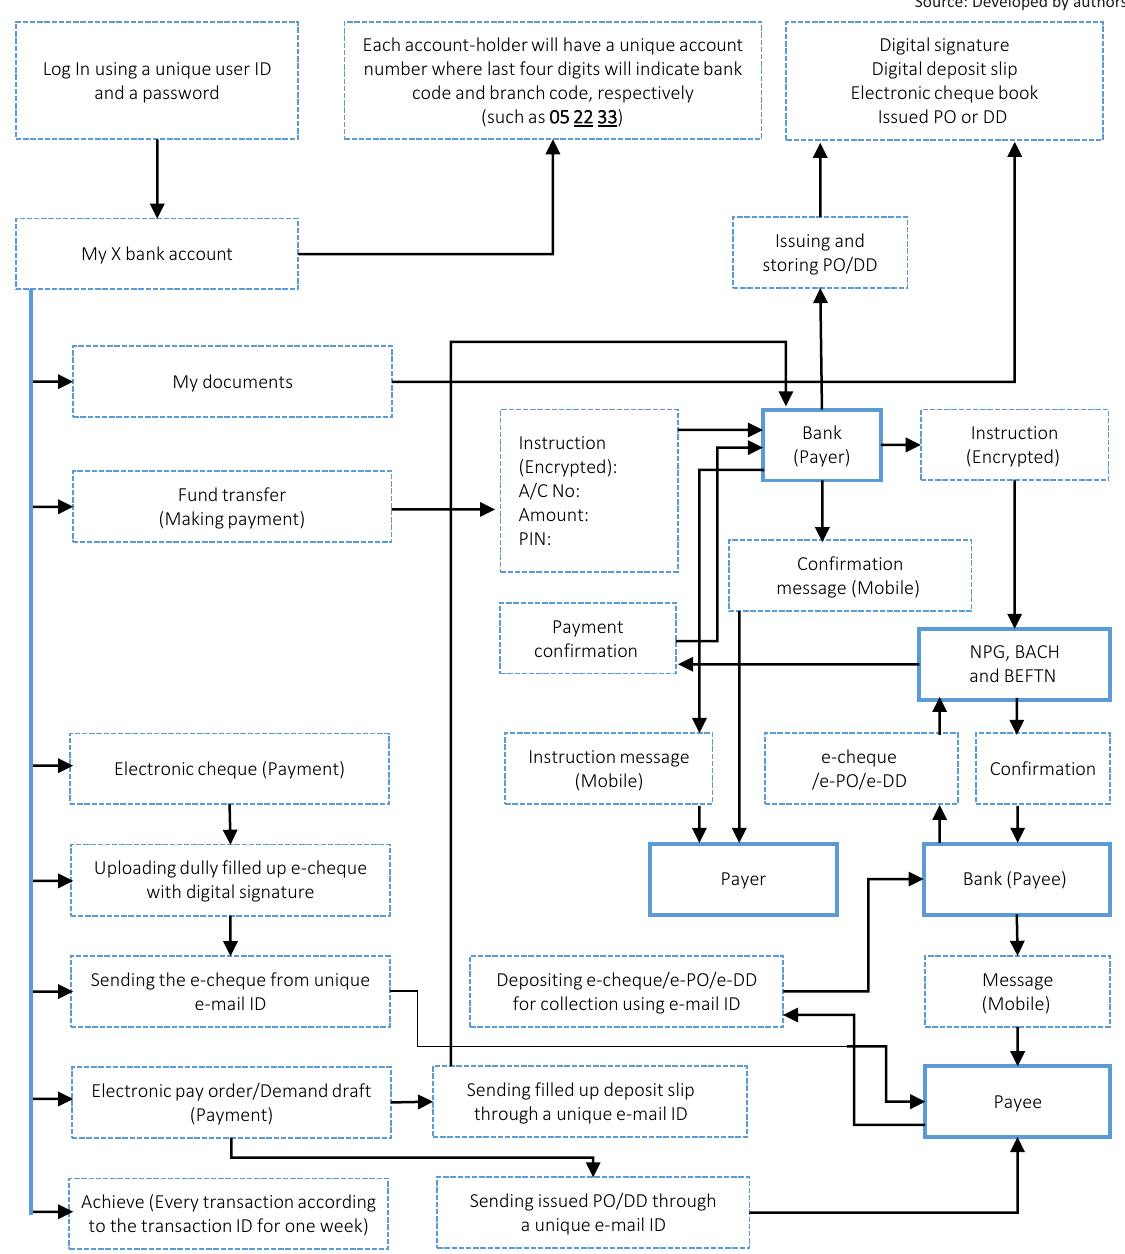
Figure 2. Secured and user-friendly